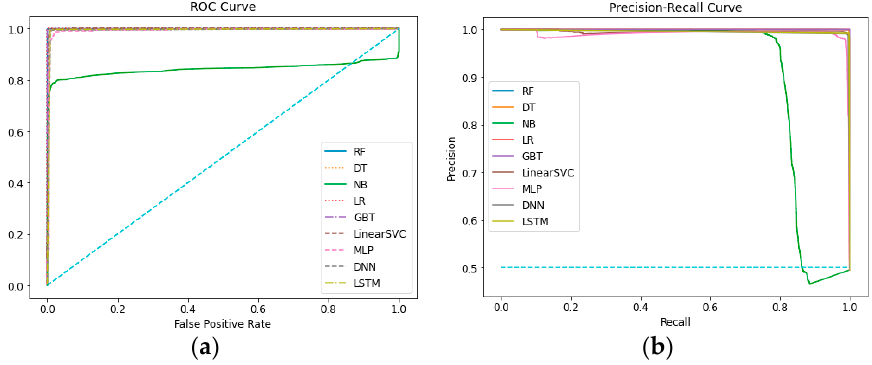
Figure 10. ( a ) ROC-AUC: comparison of ML and DL Models; ( b ) PRC-AUC: comparison of ML and DL Models.